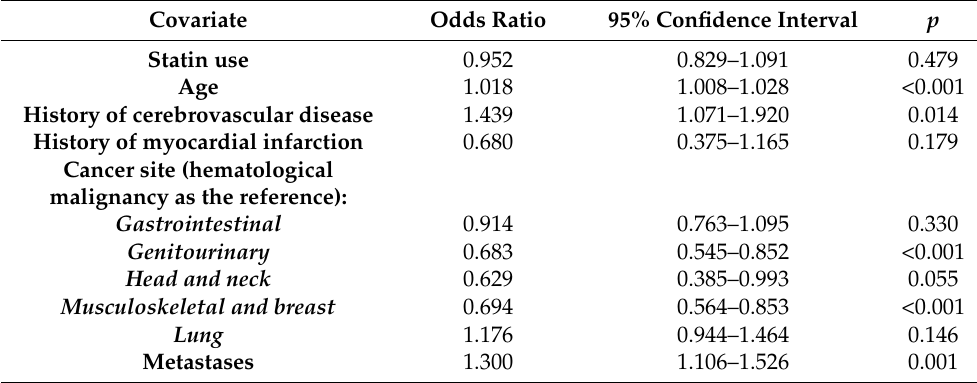
Table 5. Summary of the multivariate logistic regression model assessing the effect of covariates on hospital mortality in the subset of cancer patients hospitalized with